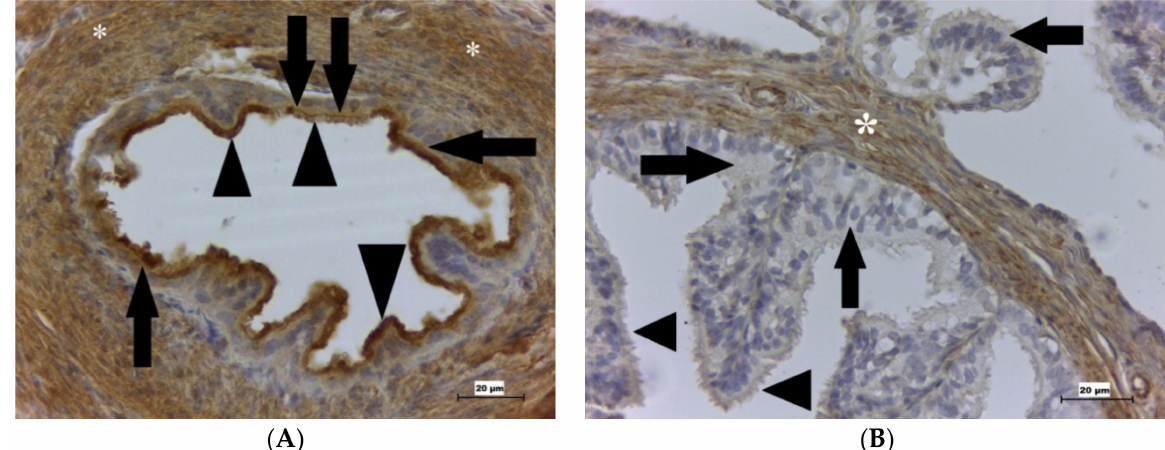
Figure 3. GPx4 presence in the rat oviduct. ( A ) Shows the rat oviduct on D1. Immunohistochemical analysis shows a cross-section of the oviduct. Kinocilia are strongly positive for GPx4 (arrowheads), the cytoplasm of the epithelial cells (arrows) and the smooth muscle cells (white asterisks) are also GPx4 positive. ( B ) Shows the rat oviduct on D5. Immunohistochemical analysis shows a cross-section of the oviduct. Kinocilia are GPx4 negative (arrowheads) together with the cytoplasm (arrows) of the epithelial cells, stromal cells (asterisk) are GPx4 positive. Scale bar = 20 µ m. GPx4 is glutathione peroxidase 4; D1 is the first day of pregnancy; D5 is the fifth day of